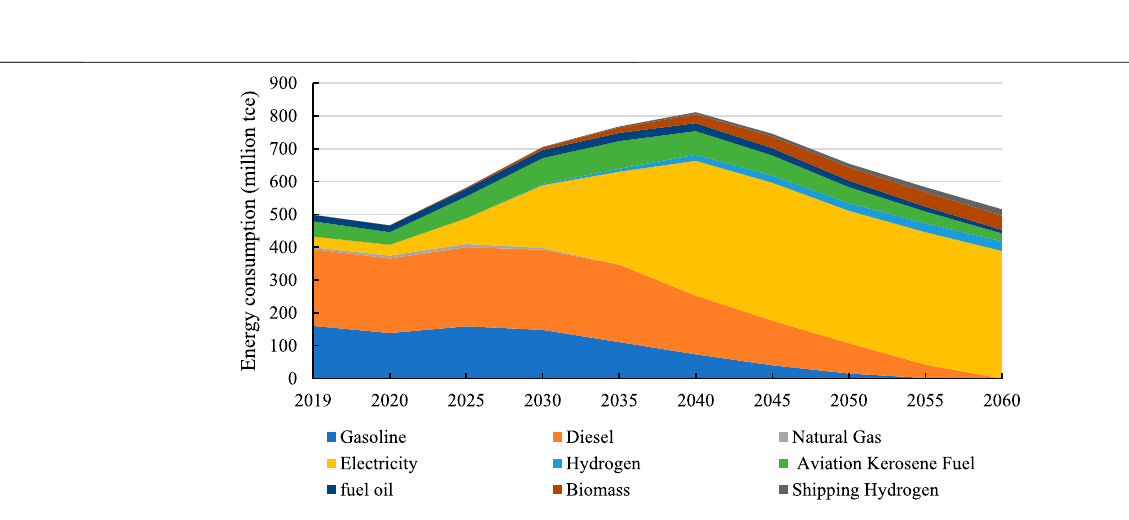
FIGURE 15 | Different fuel consumption trends under the radical